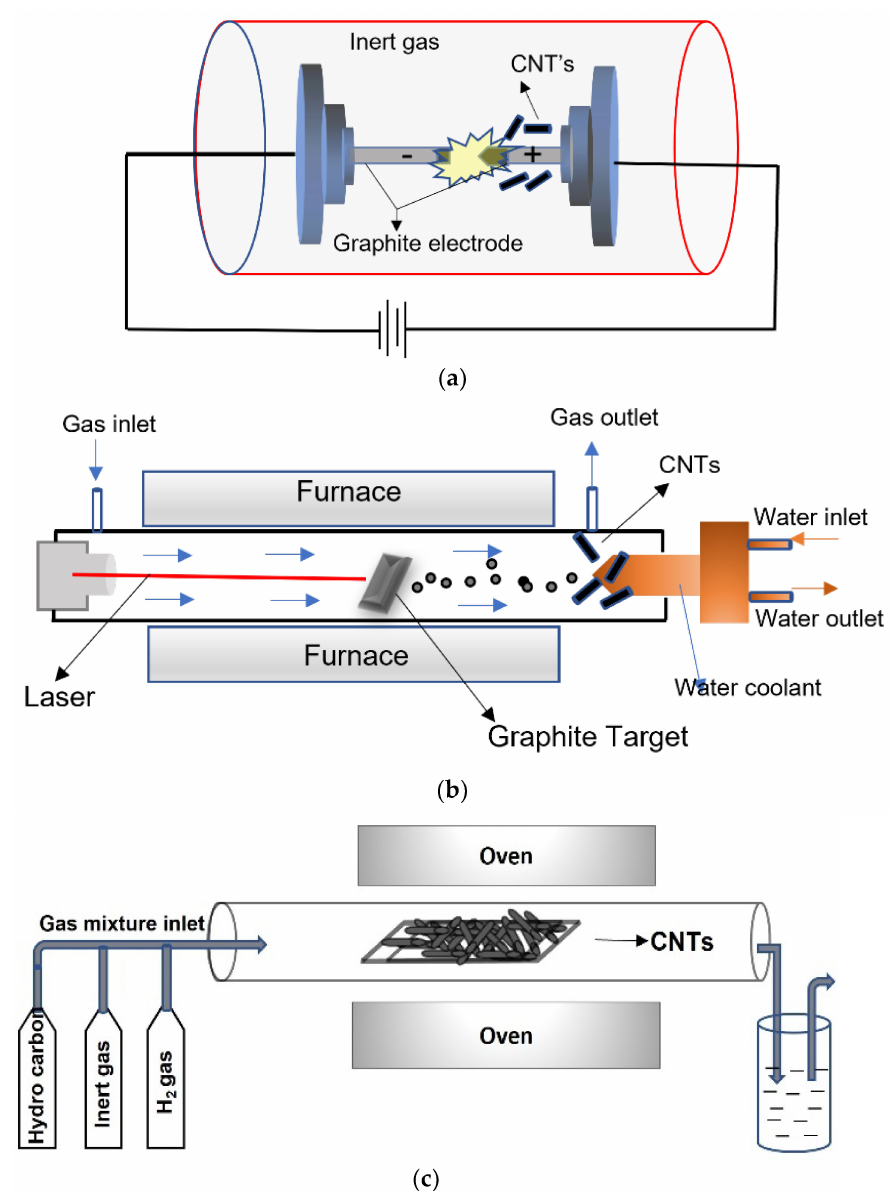
Figure 5. An illustration of CNT synthesis methods: ( a ) electric arc discharge, ( b ) laser ablation, and ( c ) chemical vapor deposition